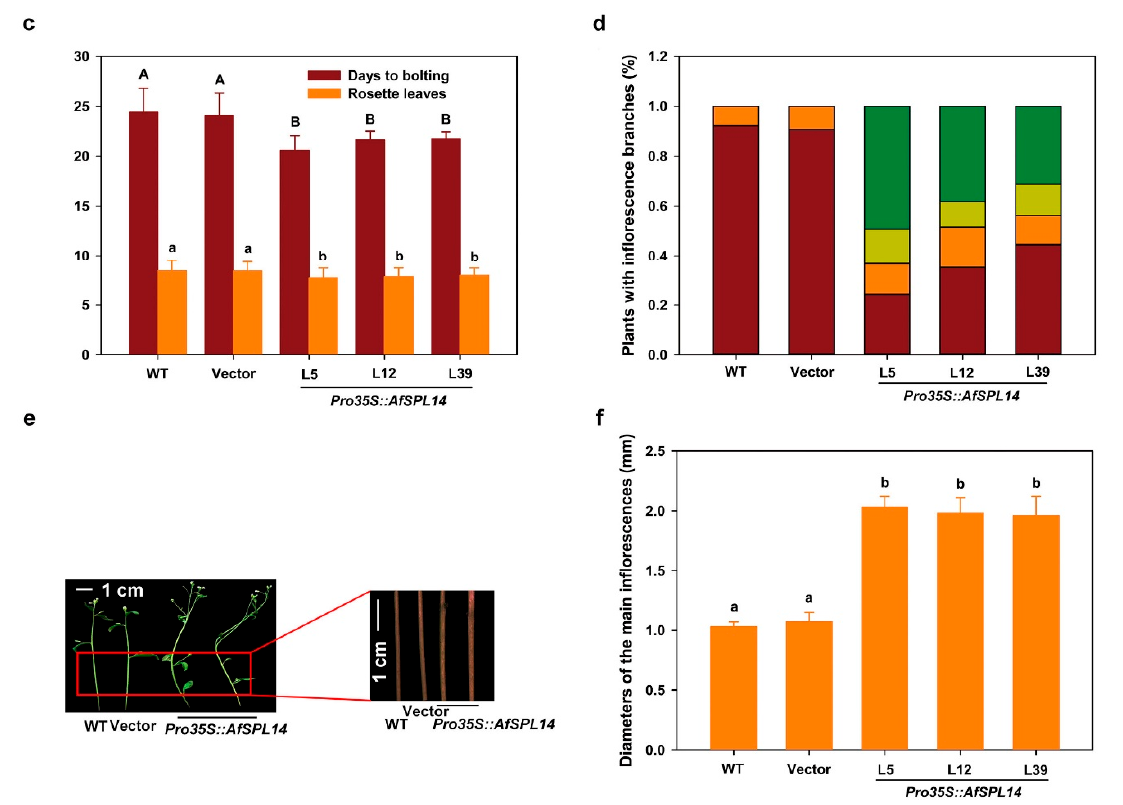
Figure 6. Phenotype analysis of Pro35S::AfSPL14 transgenic plants. ( a ) Flowering Pro35S::AfSPL14 transgenic plants shown next to WT and WT transformed with the empty vector (Vector) under LD conditions. L5, L12, L39, and L46 indicate the different lines. ( b ) Flowering Pro35S::AfSPL14 transgenic plants that had two main inflorescences under LD conditions. ( c ) Days and number of rosette leaves to bolting of the WT, Vector and Pro35S::AfSPL14 transgenic plants grown under LD conditions. Values are the means ± standard deviation. Seventy-nine plants were scored for each line. Difference letters indicate statistical differences. ( d ) Percentages of plants which have two main inflorescences grown under LD conditions. The number of plants with the second main stem developed from the base (orange), the node (ginger), and the non-node (dark green) position of the main inflorescences and plants with only one inflorescence (dark red) was calculated. One hundred and twenty-eight 38-day-old, long-day-grown plants and ninety-six 55-day-old, short-day-grown plants were counted for each line. ( e ) Bending and thicker main inflorescences of Pro35S::AfSPL14 transgenic plants under LD conditions. ( f ) The diameter of main inflorescences of WT, Vector and transgenic plants. Forty-eight 38-day-old, long-day-grown plants were counted for each line. The diameter of the positions which were 5 cm distance from the basal of the main inflorescences was measured. ANOVA was conducted, and means were separated by DNMRT.